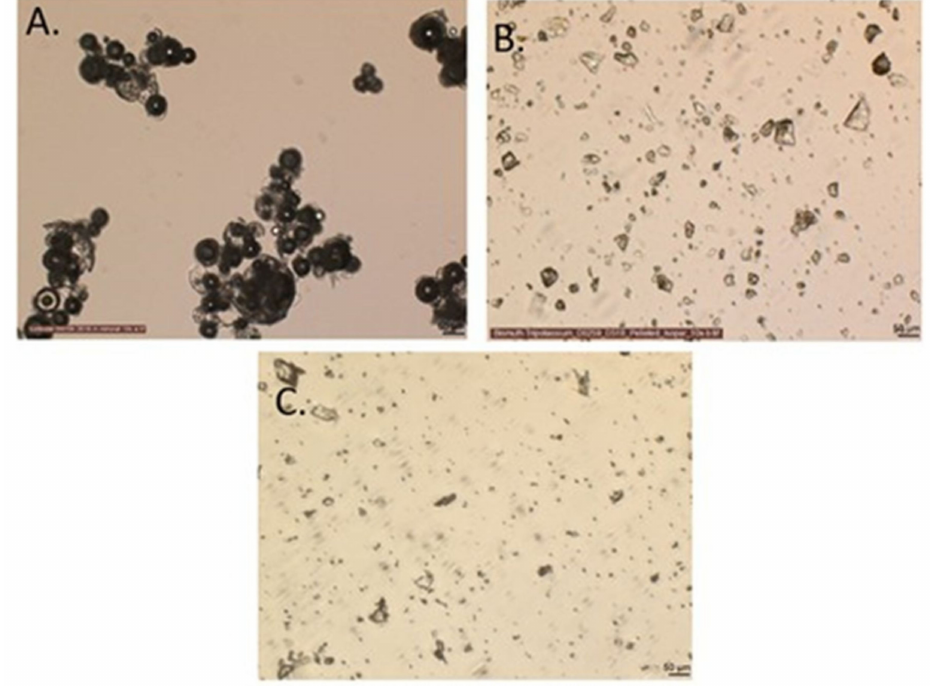
Figure 8. Optic microphotographs of original bismuth oxide API ( A ), pressed at 1 ton API ( B ) and pressed at 10 tons API ( C ) using 10 × magnification